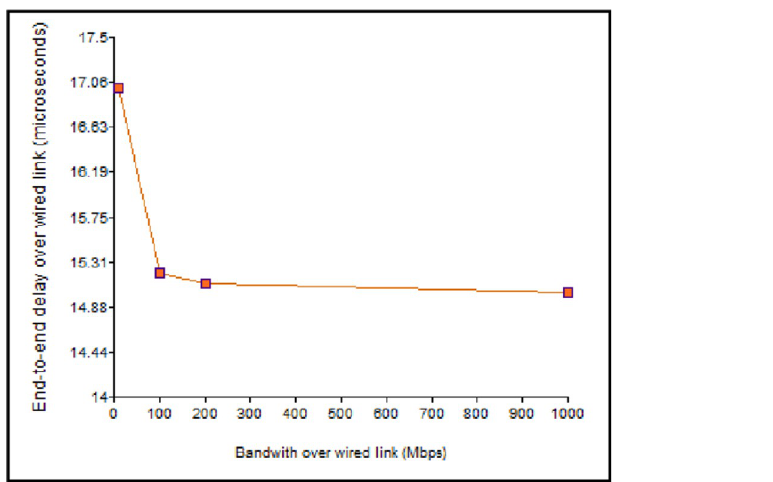
Fig 10. Impact of bandwidth on the end-to-end delay (wired